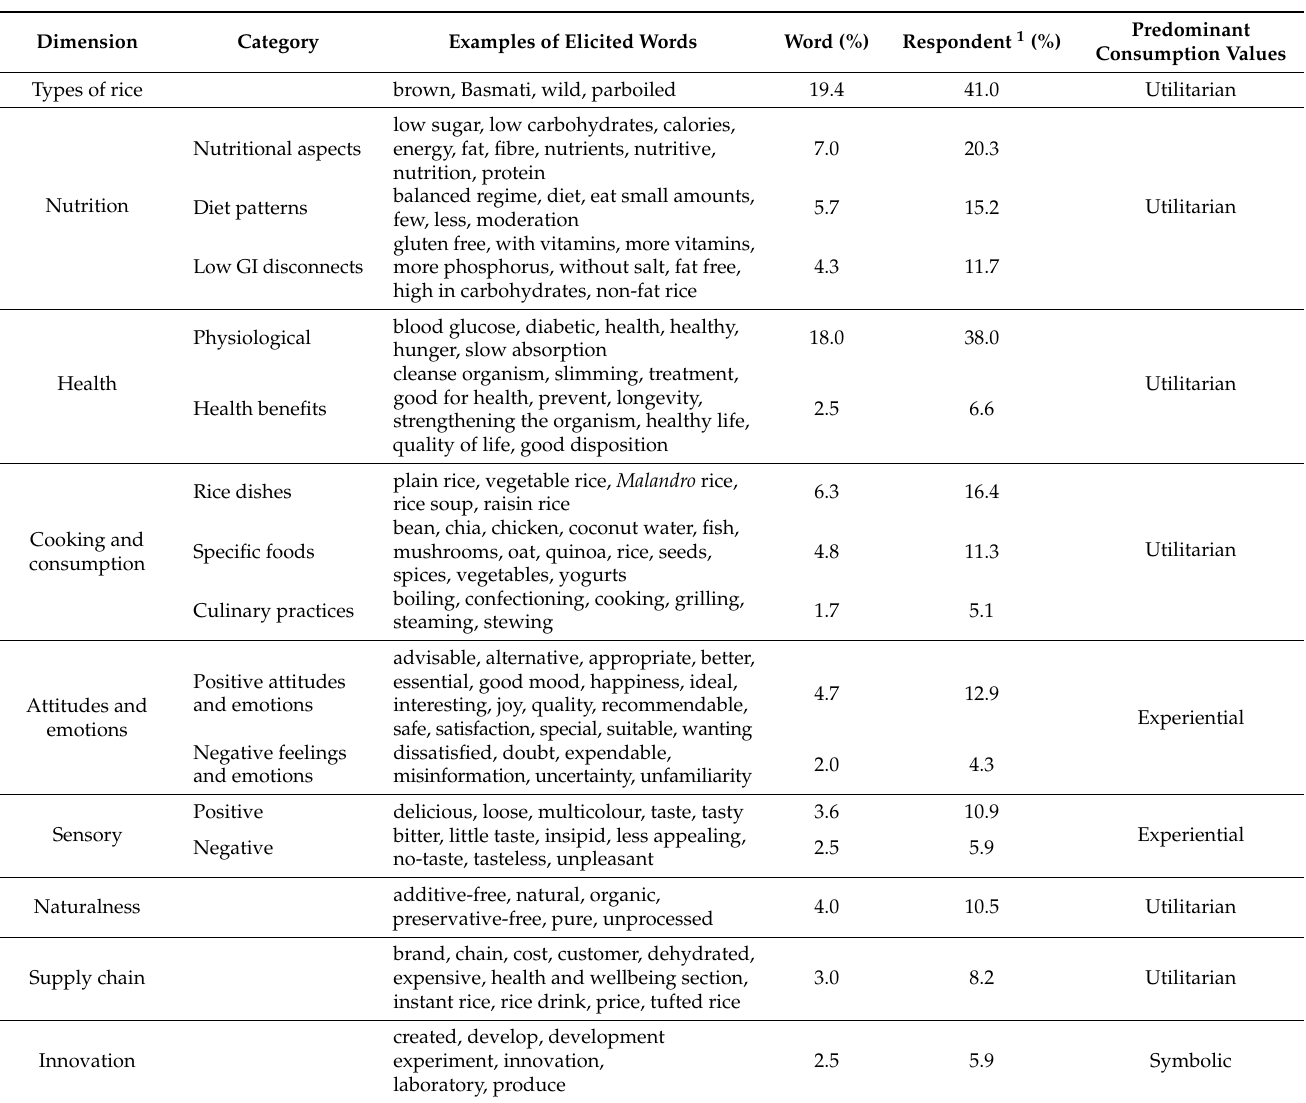
Table 3. Frequencies of words and respondents (%) according to each dimension and category for the “rice with low glycaemic index” stimulus. The predominant consumption value associated with the words within each dimension is also